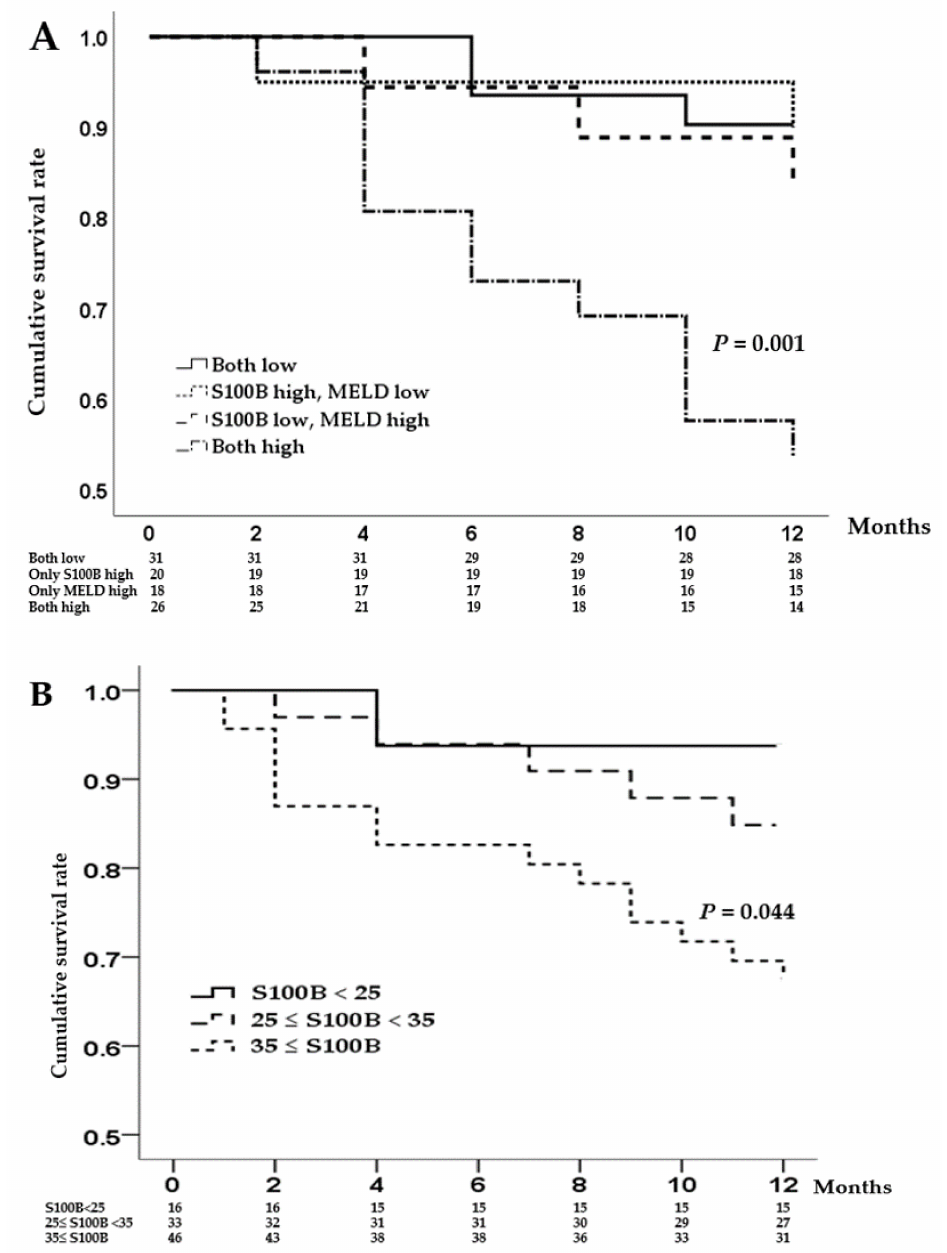
Figure 3. Kaplan–Meier curve displaying the estimated survival probability for the different groups of patients; ( A ): When the S100B level and MELD score were high, 1‑year mortality rates were sig‑ nificantly higher than other groups. ( B ): Even without the MELD score, the higher the S100B levels, the higher mortality rates were